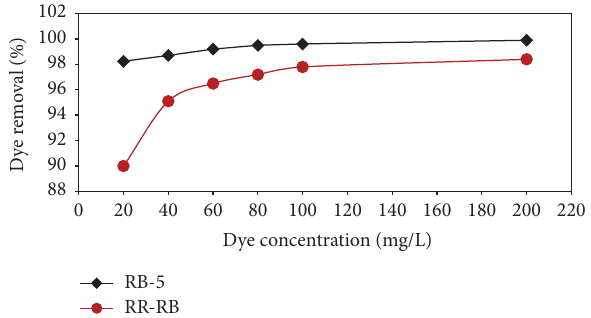
Figure 7: Effect of equal initial RR-RB and RB-5 dyes concentration on the removal efficiency of both dyes in binary system (QKCF dosage = 0.1g/100 mL, agitation speed = 200 rpm, time = 3 hr., and temp. = 25 ∘ C).